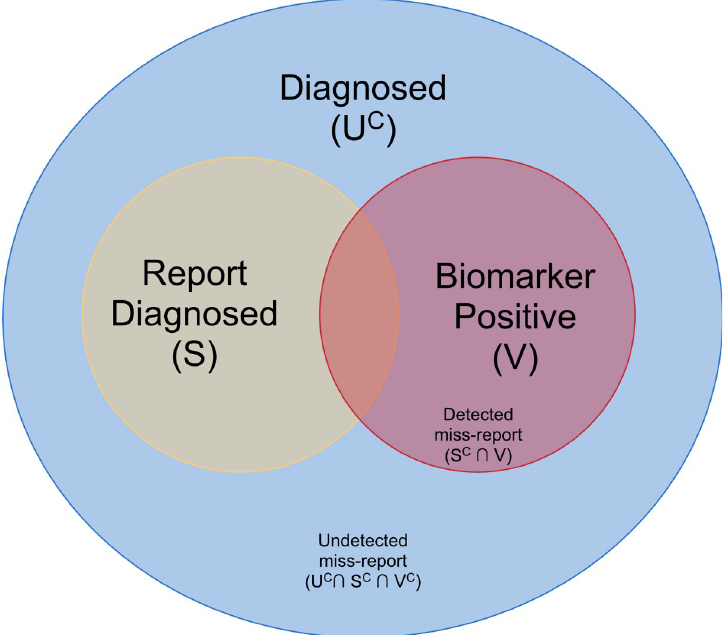
Fig 1. A Venn diagram of the relationship between true undiagnosed status and status as inferred from self- reporting and biomarker positivity.